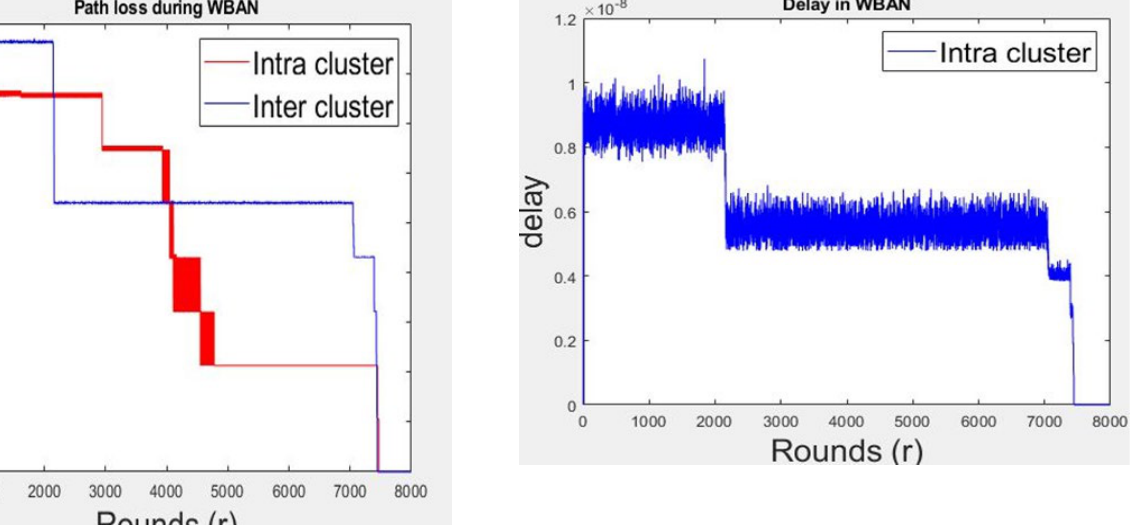
Figure 14. Delay in